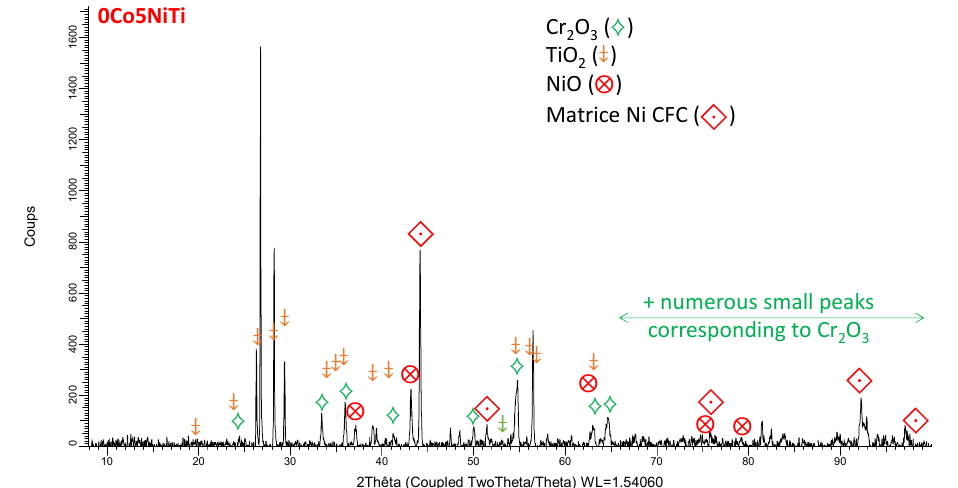
Figure 6. Diffractogram acquired on one side of the oxidized 0Co5NiTi sample.